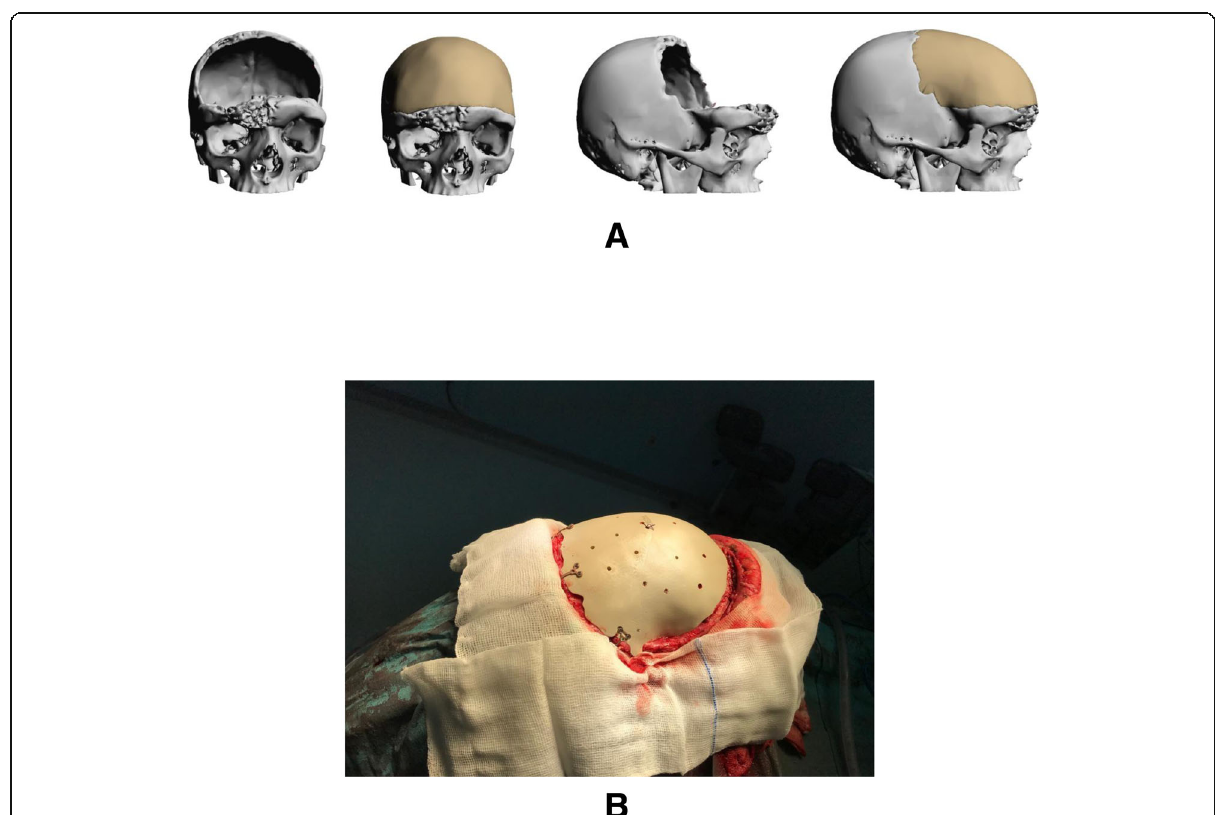
Fig. 4 Craniotomy case. a 3D reconstruction of CT showing defect and planned implants. b Intraoperative views of the cranial implant